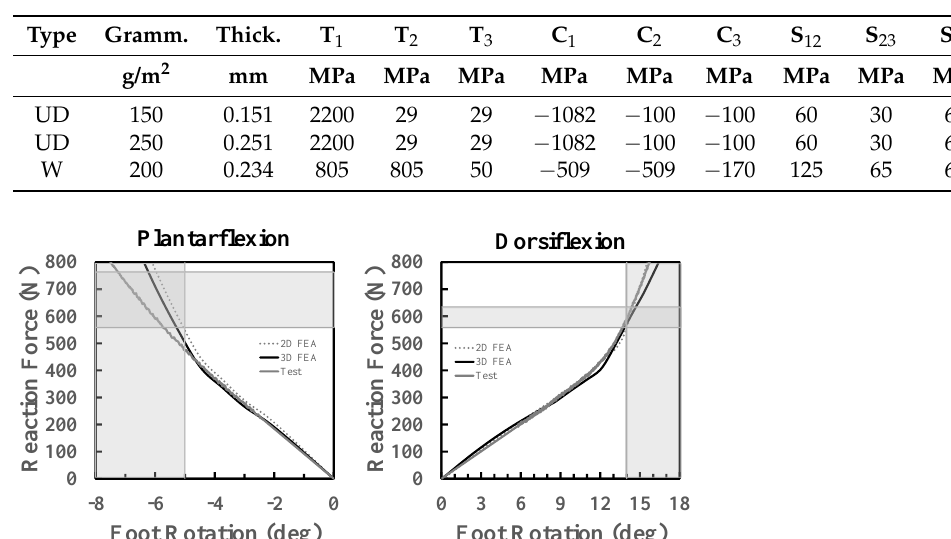
Table 9. Orthotropic strength of CFRP prepregs used to manufacture the upper blade, middle blade and lower blade. T 1 , T 2 and T 3 are the tensile strength; C 1 , C 2 and C 3 are the compressive strength; S 12 , S 23 and S 13 are the shear strength.